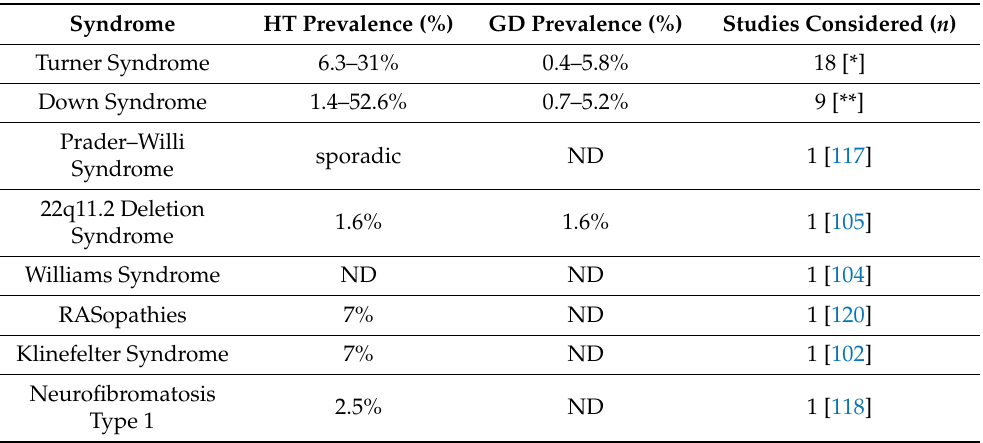
Table 2. Prevalence rate of autoimmune thyroid diseases (AITDs) among different genetic syndromes according to the reviewed